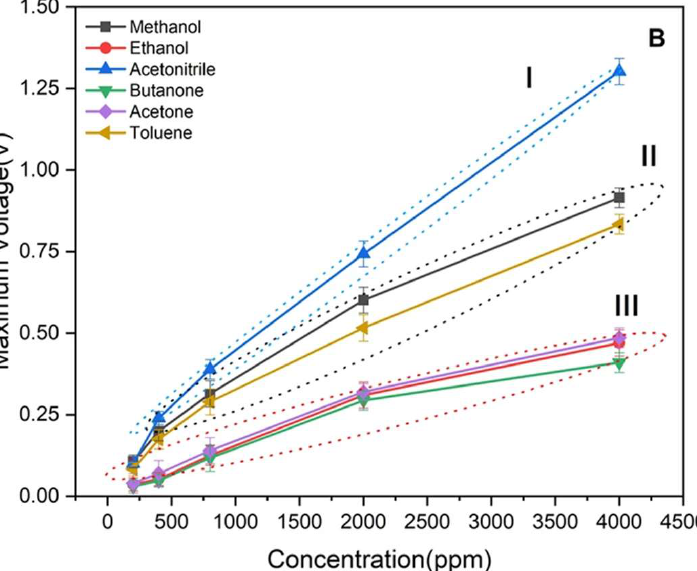
Figure 2. Janfaza et al. produced a MIP via conventional template imprinting for acetone, but the polymer shows porogen imprinting for acetonitrile. MIPs were synthesized by the polymerization of ethylene glycol dimethacrylate and methacrylic acid with acetone (3:1:1) in dry acetonitrile. The resulting polymer was ground to powder, dispersed in acetonitrile and drop−casted onto an electroactive microfluidic sensor, permitting monitoring resistance variation. I, II and III refer to different clusters of responses determined from this result. Reproduced with permission [41].